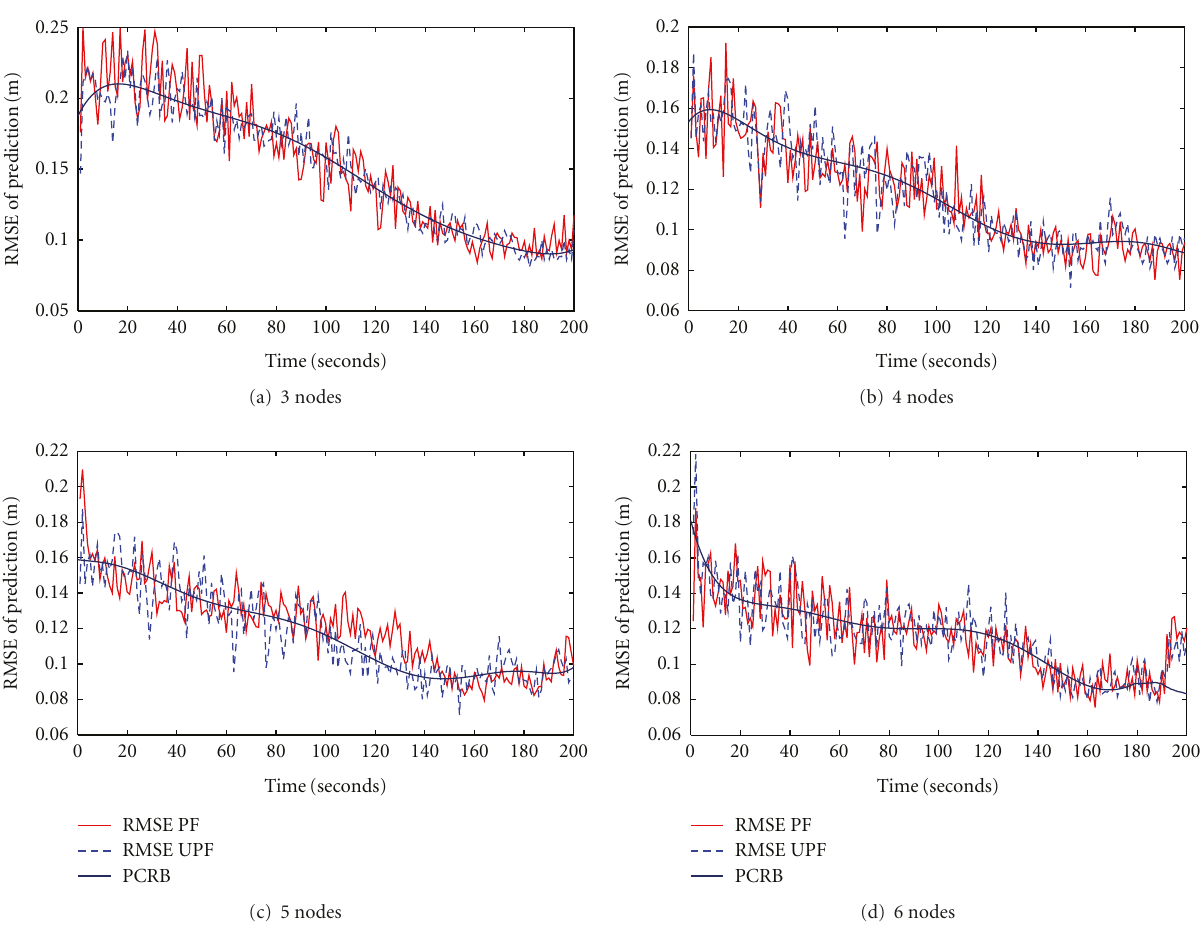
Figure 4: Compared tracking error versus time with target velocity =